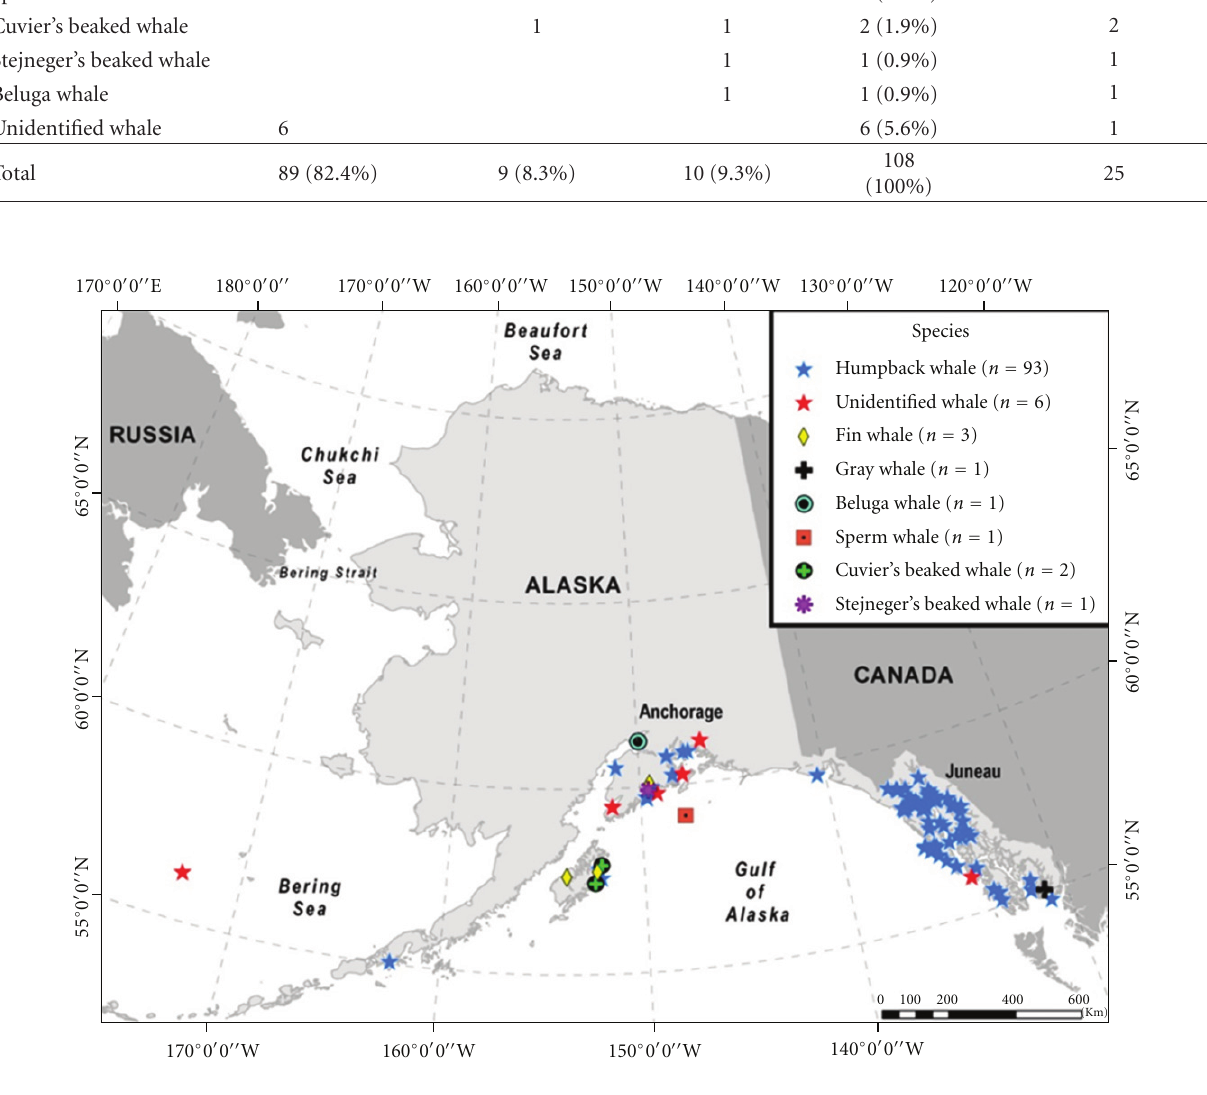
Figure 1: Location of whale-vessel collision reports in Alaska by species 1978–2011 ( n = 108). Rejected reports are not